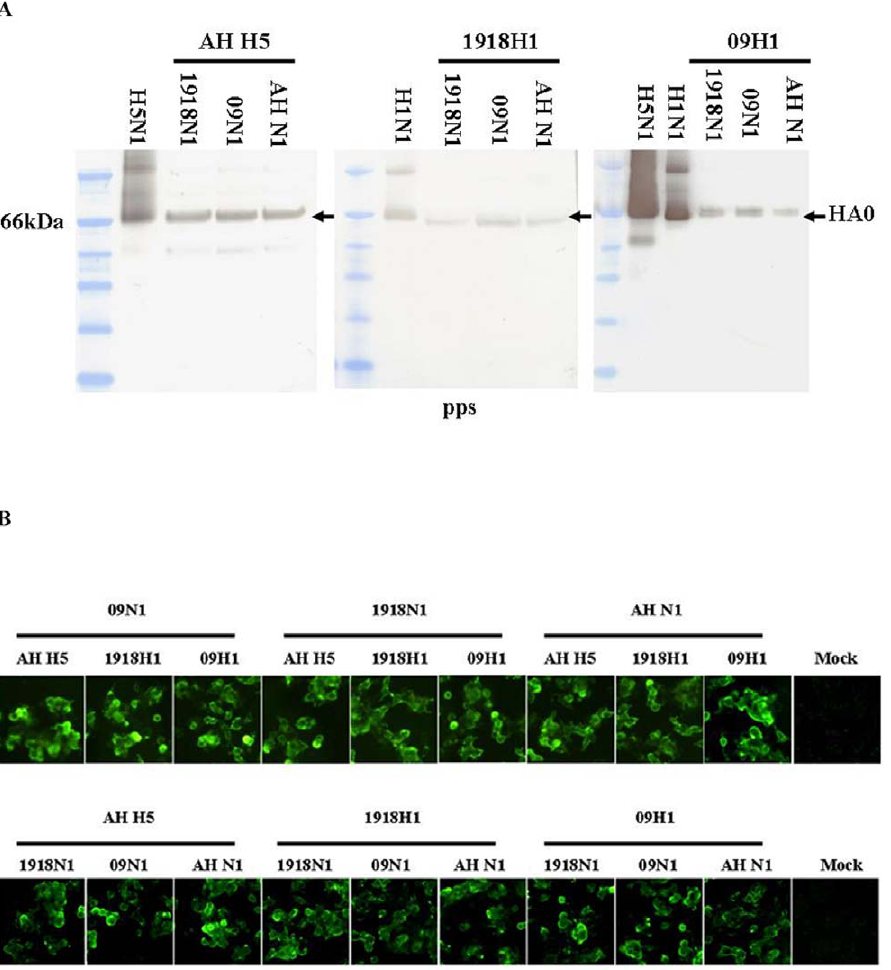
Figure 2. HA/NA expression analysis. A. Western blot of HA. HA of each pp combination was blotted with purified 300ng wild viruses as positive control (H5N1: A/Vietnam/1194/2005; H1N1: A/Carifornia/7/2009). B. Immunocellular staining of HA and NA on pp producer 293T cells. HA (bottom) and NA (upper). Mock, normal 293T cell lysate.